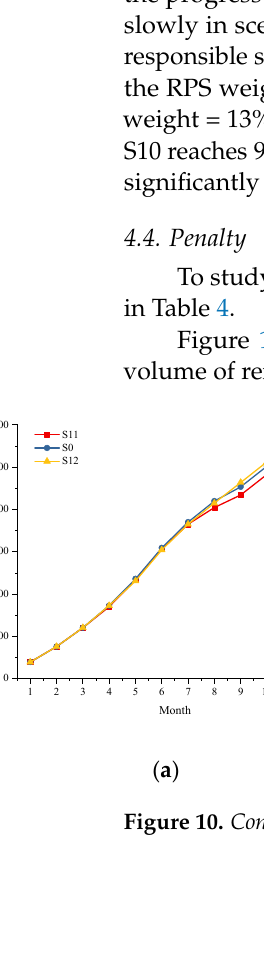
Table 4. Scenarios for analyzing the impacts of penalties.